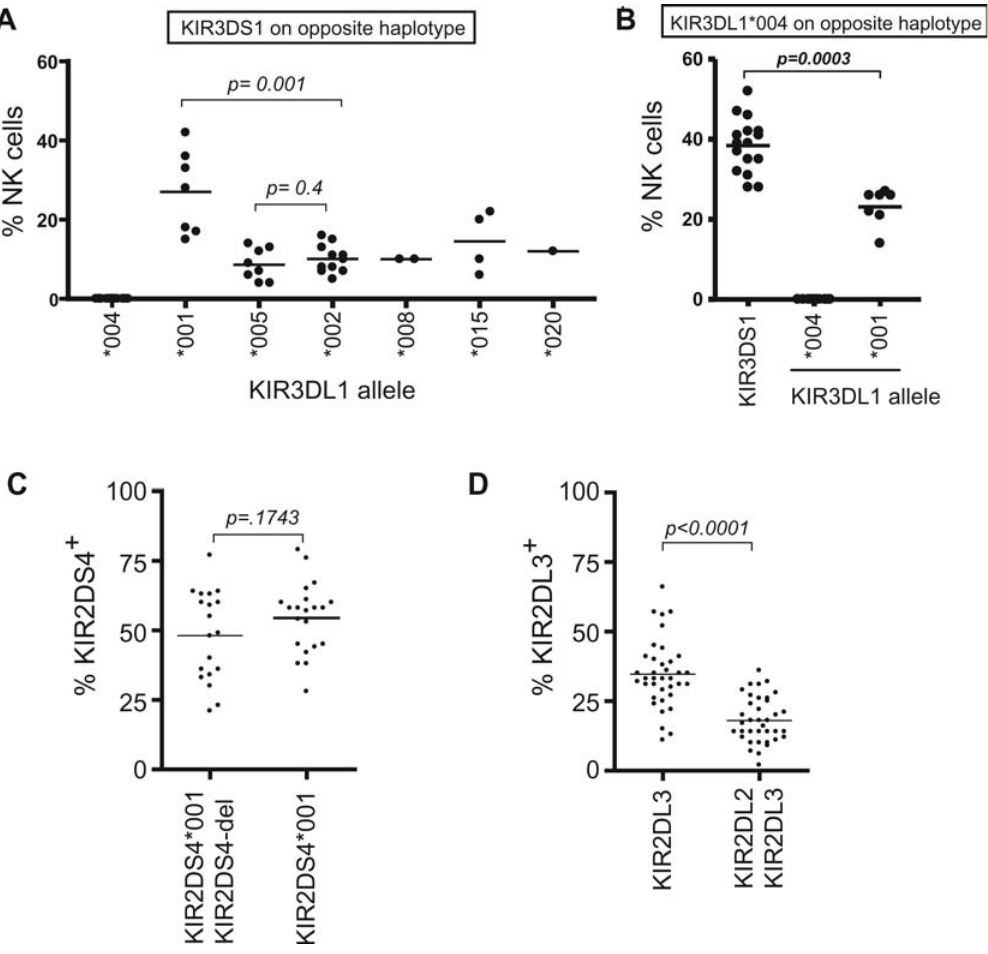
Figure 5. Frequency of expression of KIR3DL1/S1, KIR2DS4 and KIR2DL3 on the NK cell population. (A) The percentage of NK cells expressing KIR3DL1 in donors containing only one expressed inhibitory allele is indicated for individuals with a KIR3DS1/3DL1 genotype. (B) The percentage of NK cells expressing either KIR3DS1 or the indicated KIR3DL1 allotypes was determined in individuals heterozygous for KIR3DS1 or KIR3DL1 and the KIR3DL1*004 allele (*004 is not expressed on the NK cell surface). (C) The percentage of donor peripheral blood NK cells expressing KIR2DS4 is shown. Individuals are grouped based on the presence of the expressed allele or the non-expressed KIR2DS4 alleles that possess a 22 bp deletion ( KIR2DS4 -del) Heterozygous KIR2DS4*001/KIR2DS4 -del donors possess one expressed KIR2DS4 allele, whereas KIR2DS4*001 (in the absence of the null allele) individuals are expected to possess one copy of KIR2DS4 but could potentially contain a second KIR2DS4*001 allele. (D) Expression of KIR2DL3 on peripheral blood NK cells is shown. Individuals typed as possessing KIR2DL3 virtually always have two copies of the gene, whereas donors that have KIR2DL2/2DL3 are expected to have only a single copy of KIR2DL3 .